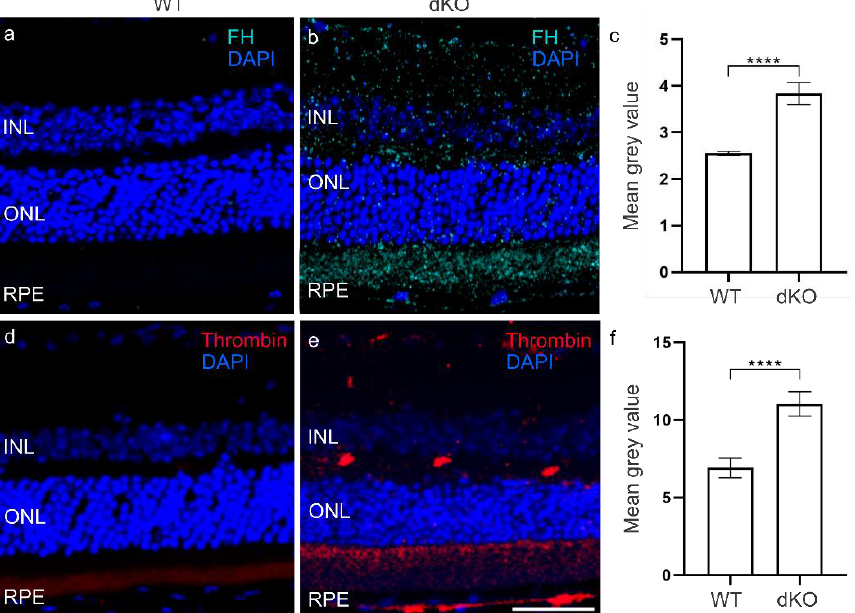
Figure 4. Analysis of levels of complement regulator factor H were significantly elevated by ~50%, **** p = 0.0001 ( c ), in dKO ( b ) compared to WT retina ( a ). The thrombin levels were significantly increased by ~60% in dKO retina ( e ), **** p = 0.0001 ( f ) compared to WT retina ( d ). Scale = 20 µm.